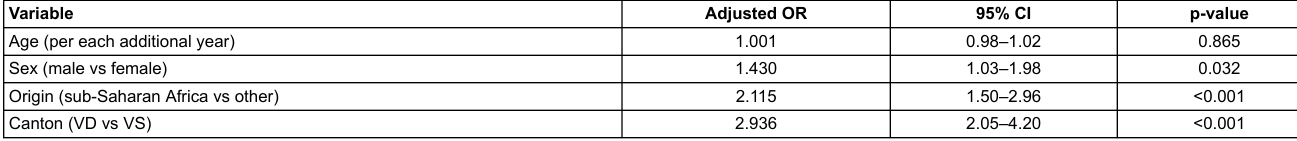
Table 3: Multivariable analysis of factors associated with the acceptance of HIV screening.